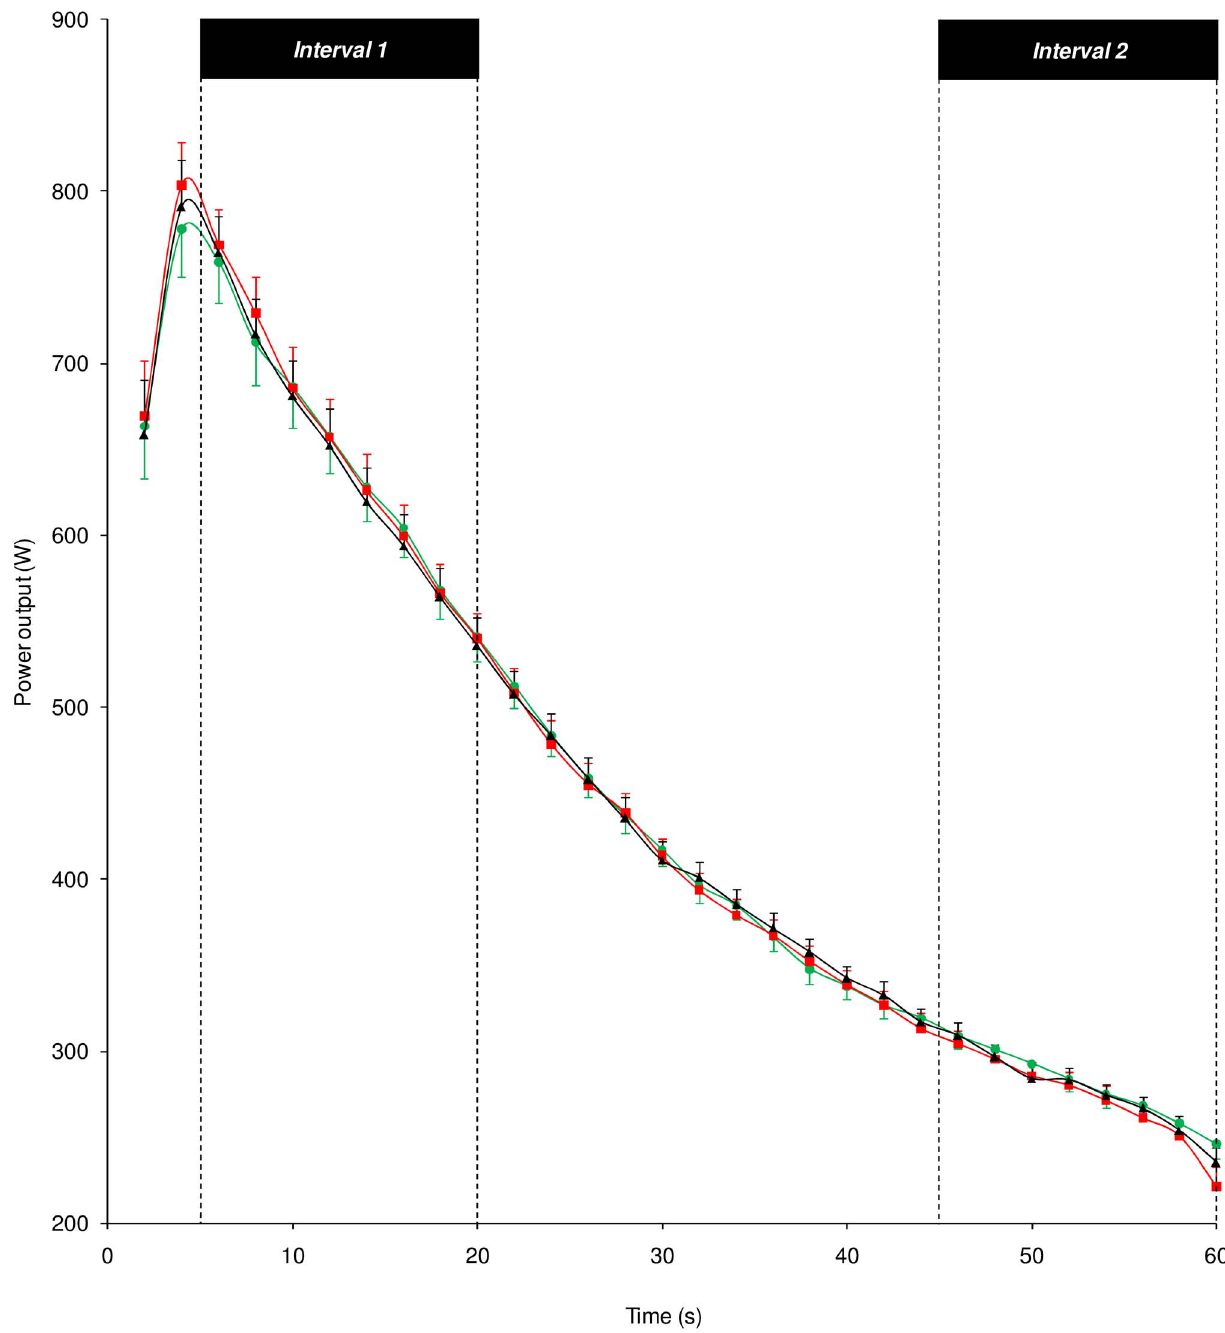
Figure 4. Evolution of power output values recorded throughout the 60-s Wingate test. Evolution of power output values as a function of time points throughout the 60-s Wingate test after a reference night or RN (green symbols), a control night or CN (red symbols) and an experimental night or EN (black symbols). Intervals 1 and 2 during which kinetic and kinematic variables were recorded and analyzed are shown. Data are mean 6 SEM ( n